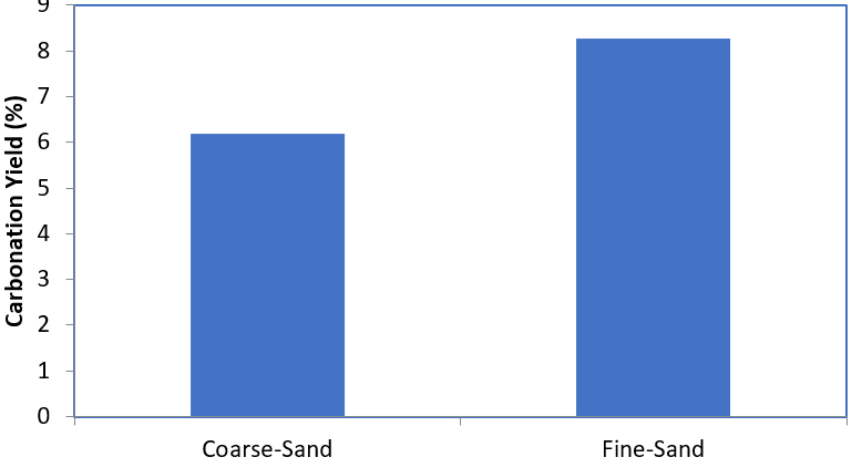
Figure 6. Carbonation yield at 5 bar pressure, 6 h carbonation time and 104 h curing time.